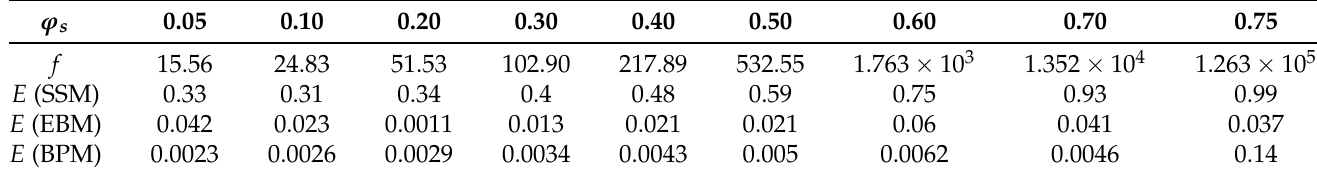
Table 1. The dimensionless drag force f versus the solid volume fraction ϕ s = π r 2 / L 2 [83]. The relative error in the drag force E = ( f num f ) / f for the simple splitting (SSM), embedded boundary (EBM), and Brinkman penalization methods − (BPM). The same maximum level of refinement J max = 10 is used for all three methods. The BPM is used with penalization coefficient η = 10 − 6